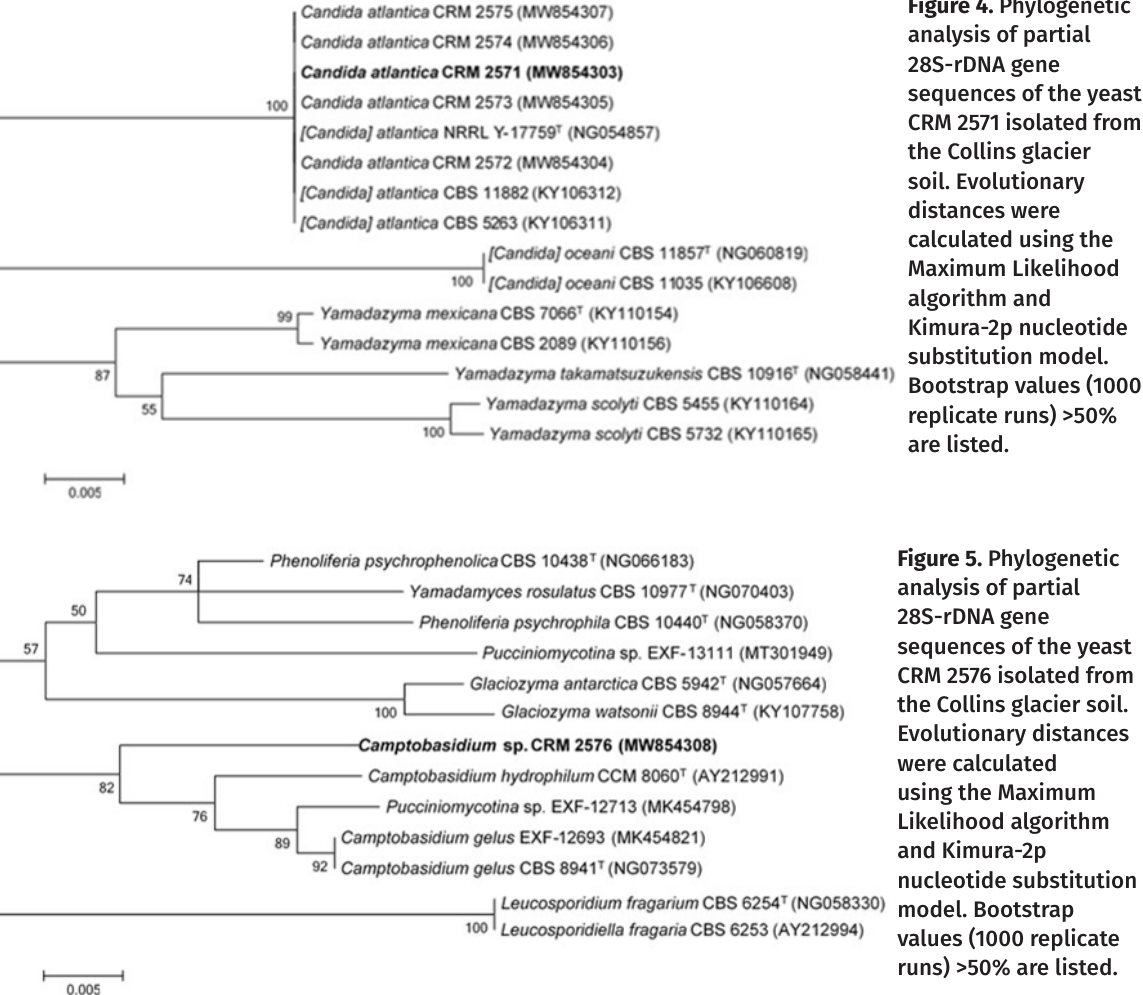
Figure 4. Phylogenetic analysis of partial